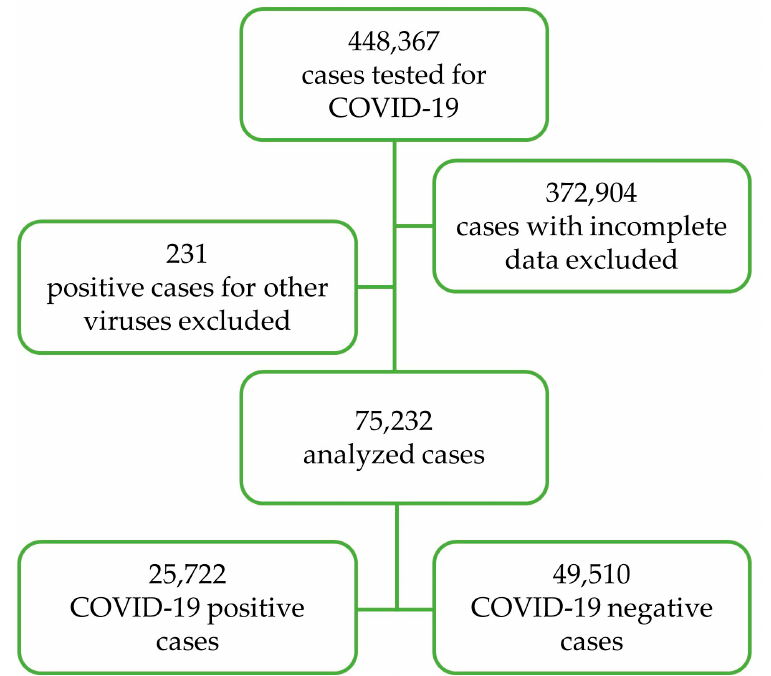
Figure 1. Schematic representation of data depuration.